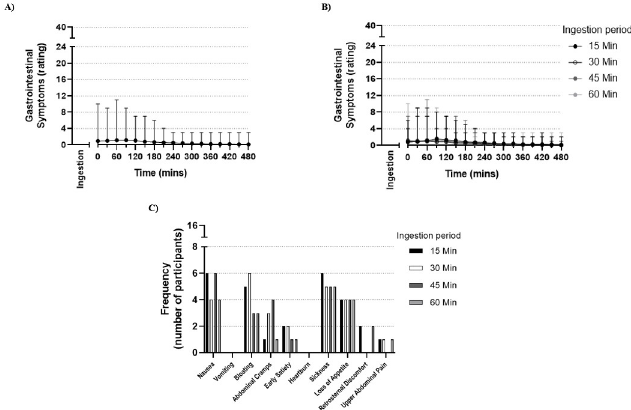
Fig 3. Gastrointestinal symptoms after 500 mg.kg -1 BM sodium citrate ingestion. (A) Mean and range of gastrointestinal symptoms (rating) following completion of ingestion of sodium citrate, with a maximum possible rating of 40 at each time-point, irrespective of ingestion period ( n = 16 participants, 4 sessions per participant, 64 total observations). (B) Mean and range of gastrointestinal symptoms (rating) following completion of ingestion of sodium citrate over 15, 30, 45 or 60 min, with a maximum possible rating of 40 at each time-point ( n = 16 participants per ingestion period). (C) Frequency of each gastrointestinal symptom reported by all participants after ingestion of sodium citrate over 15, 30, 45 or 60 min ( n = 16 participants). For both (A) and (B), zero (0) value on the x-axis corresponds to the completion of sodium citrate